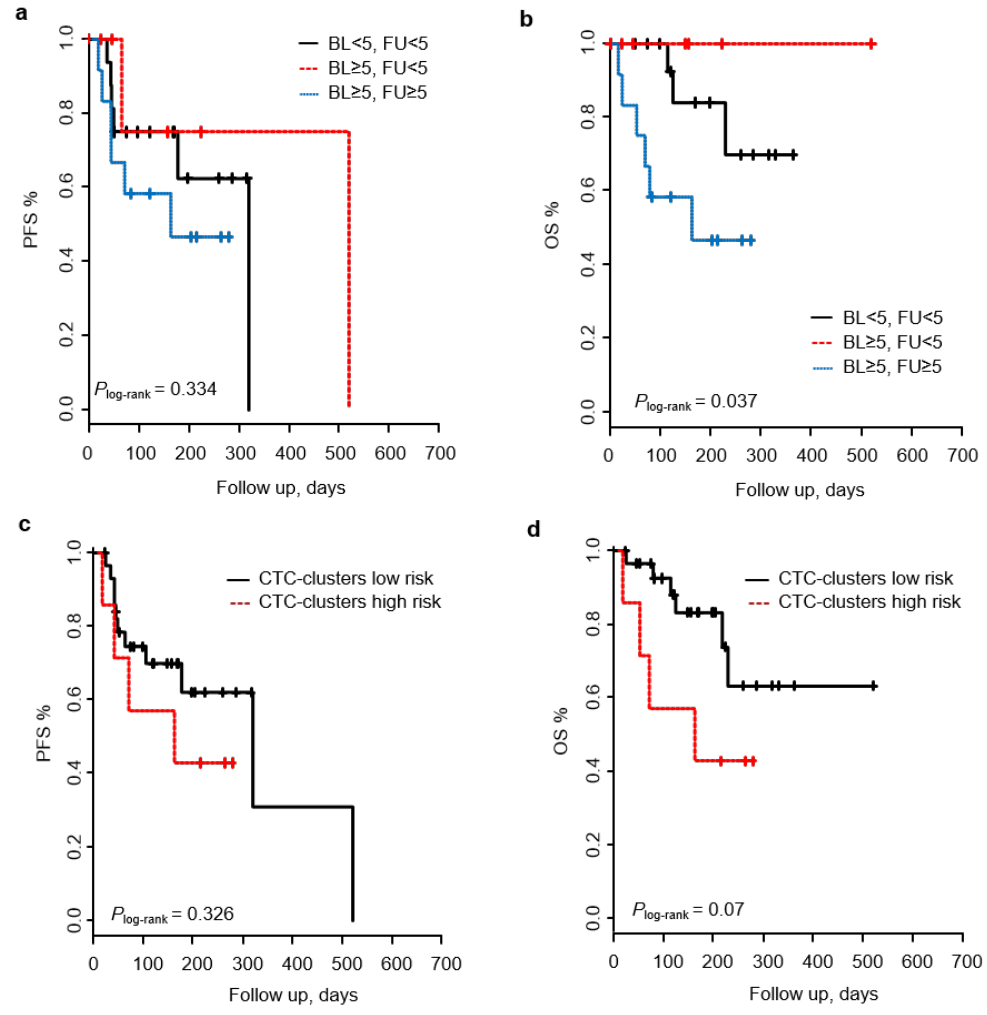
Figure 4. Baseline-to-follow up changes in CTCs and CTC-clusters in relation to patient outcome. Based on CTC counts, Kaplan–Meier curves displaying PFS and OS for the three risk group established: < 5 CTCs both at baseline (BL) and follow up (FU); ≥ 5 CTCs at BL and < 5 CTCs at FU; and ≥ 5 CTCs both at BL and FU ( a , b ). Based on CTC-cluster counts, Kaplan–Meier curves displaying PFS and OS for the two risk groups established, patients without CTC-clusters at both time points or with a reduction in the number from BL to FU (low risk); and patients whose CTC-cluster count did not change or increase over time (high risk) ( c , d ).